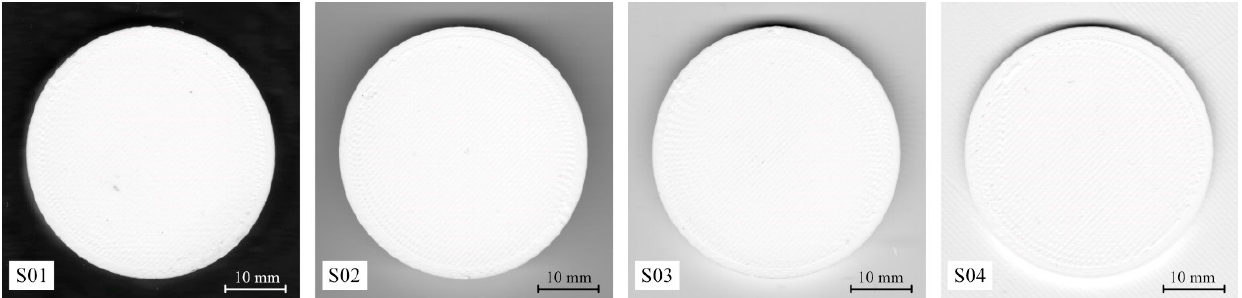
Figure 6. Raw images ( 𝐼0𝑥 ) captured for 𝑆01 , 𝑆02 , 𝑆03 and 𝑆04 contrast scenarios.